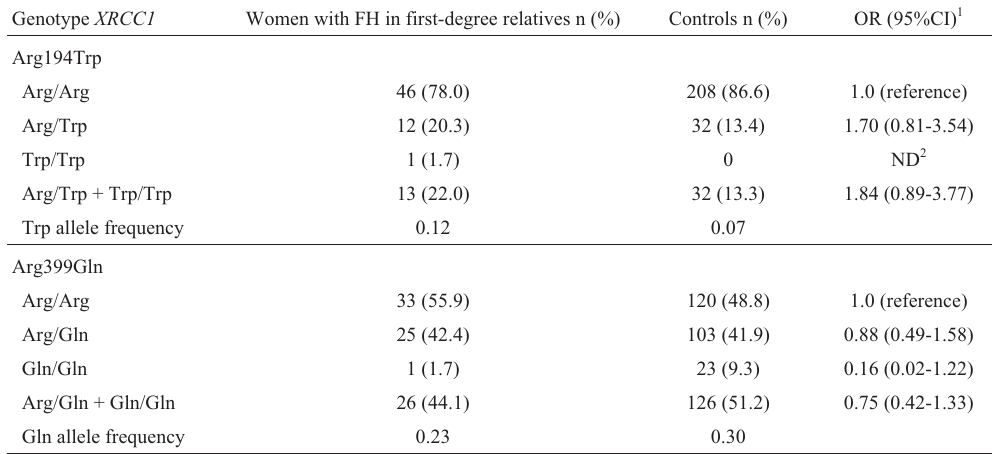
Table 4 - Allele and genotype frequencies of polymorphisms XRCC1 -Arg194Trp and XRCC1 -Arg399Gln in women reporting a family history (FH) of breast cancer in first-degree relatives and controls. Genotype XRCC1 Women with FH in first-degree relatives n (%) Controls n